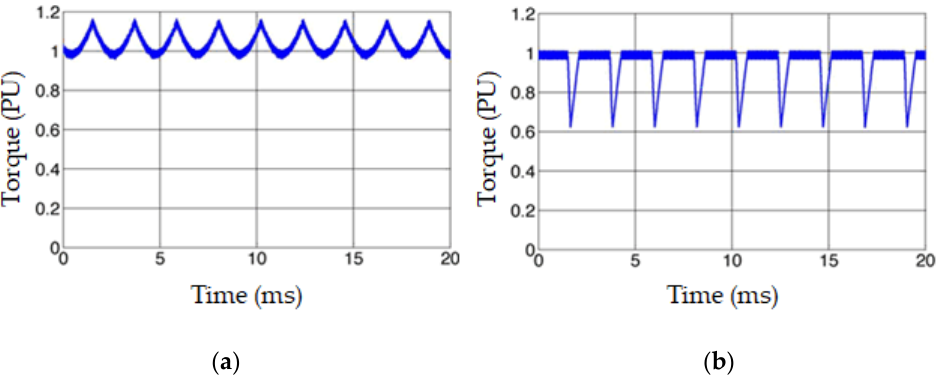
Figure 8. Simulated torque waveform for ( a ) PMBLDC fed by TPRBI, i.e., sinusoidal phase current injection, ( b ) PMBLDC fed by VSI, i.e., square wave current injection.